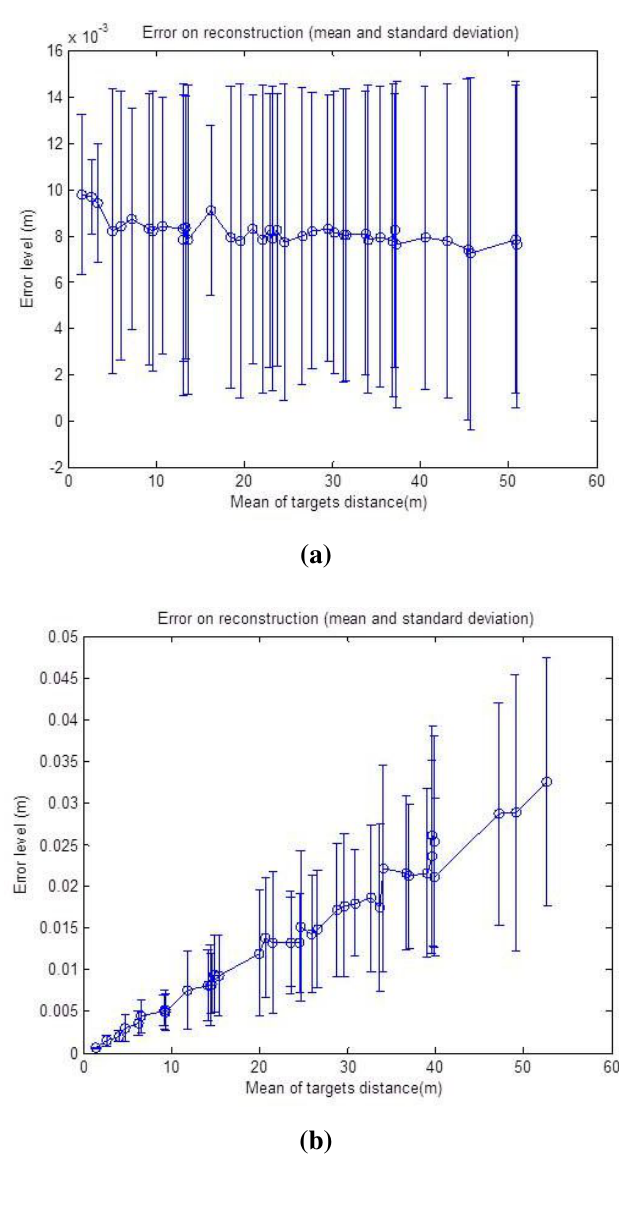
Figure 14. Reconstruction error with respect to the mean depth of the targets. The error is in meters. The mean and standard deviation of the RMSE, over 50 reconstructed points, are shown. ( a ) Noise added corresponding to 0 p, ± 2 ◦ for α and ± 2cm for r ; ( b ) Noise added corresponding to ± 2 p, 0 ◦ for α and 0 cm for r